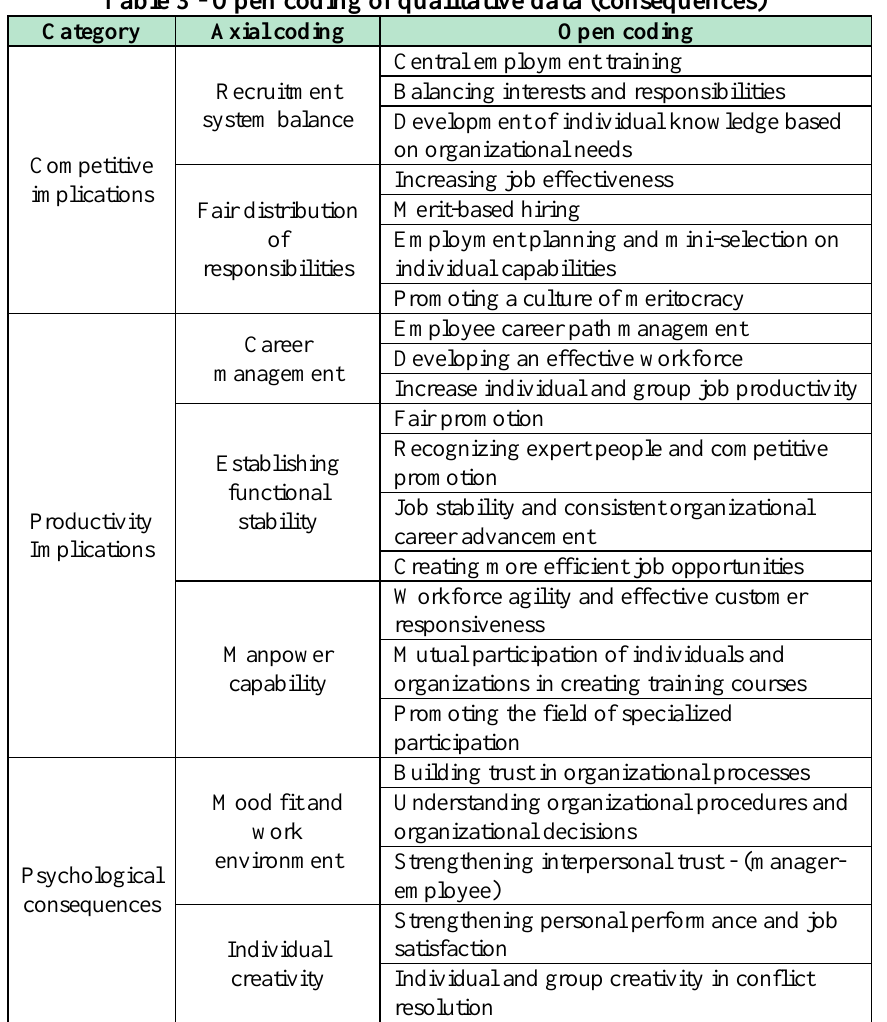
Table 3 - Open coding of qualitative data